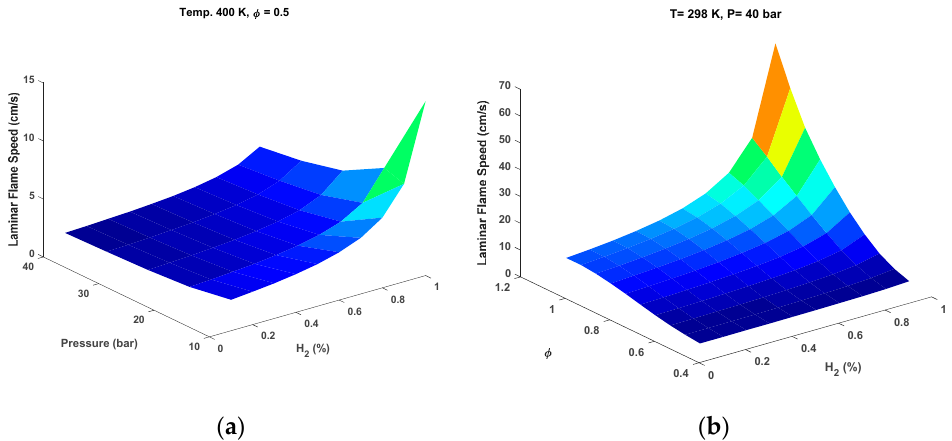
Figure 13. Effect of H 2 addition on methane’s laminar flame speeds at: ( a ) different pressure at T = 400 K, Φ = 0.5; ( b ) different equivalence ratios at T = 298 K, p = 40 bar.